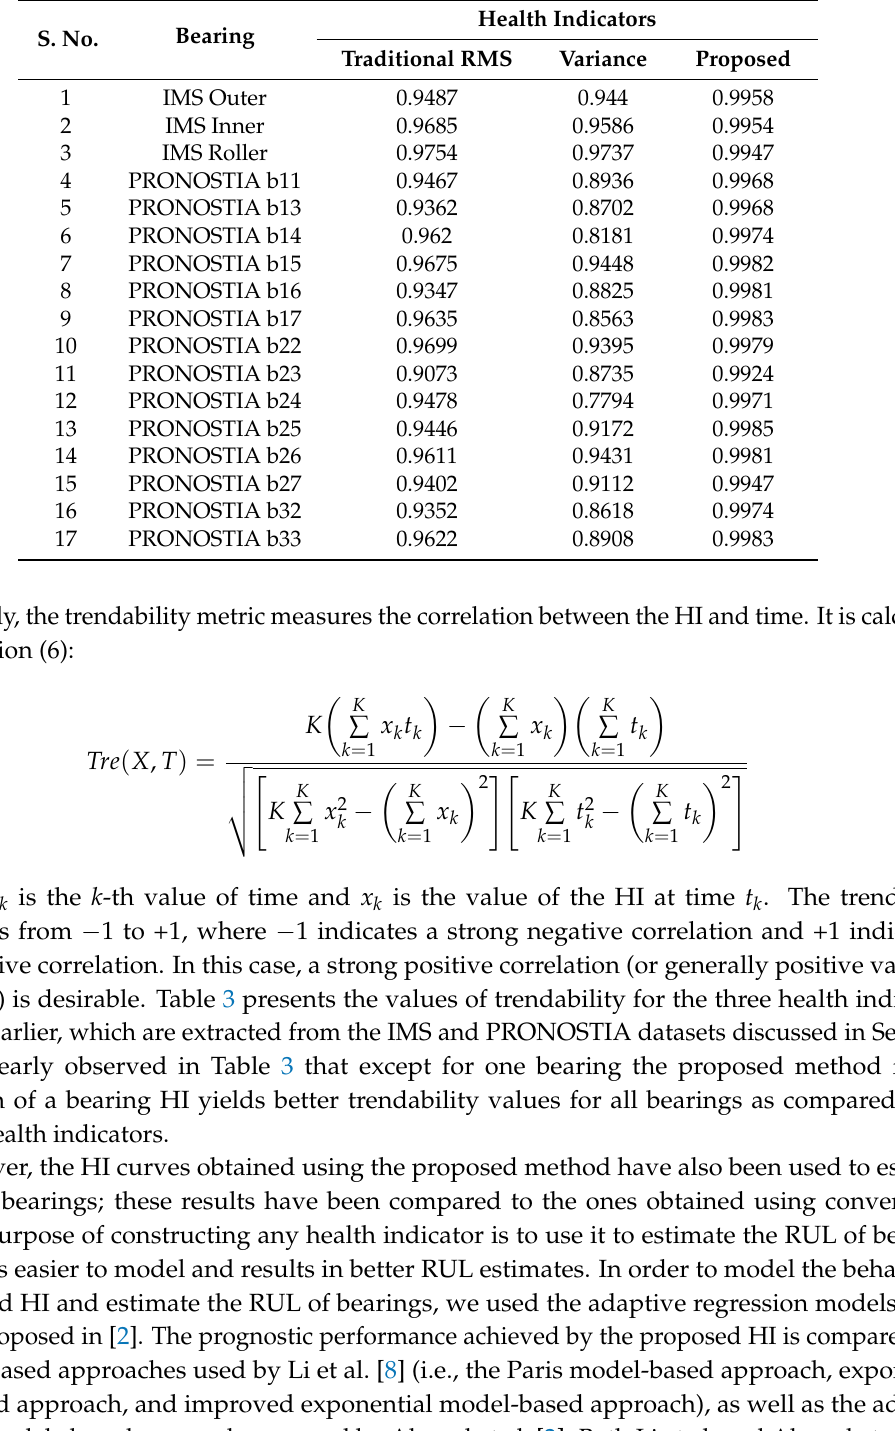
Table 2. Quantitative Evaluation of the Health Indicators using